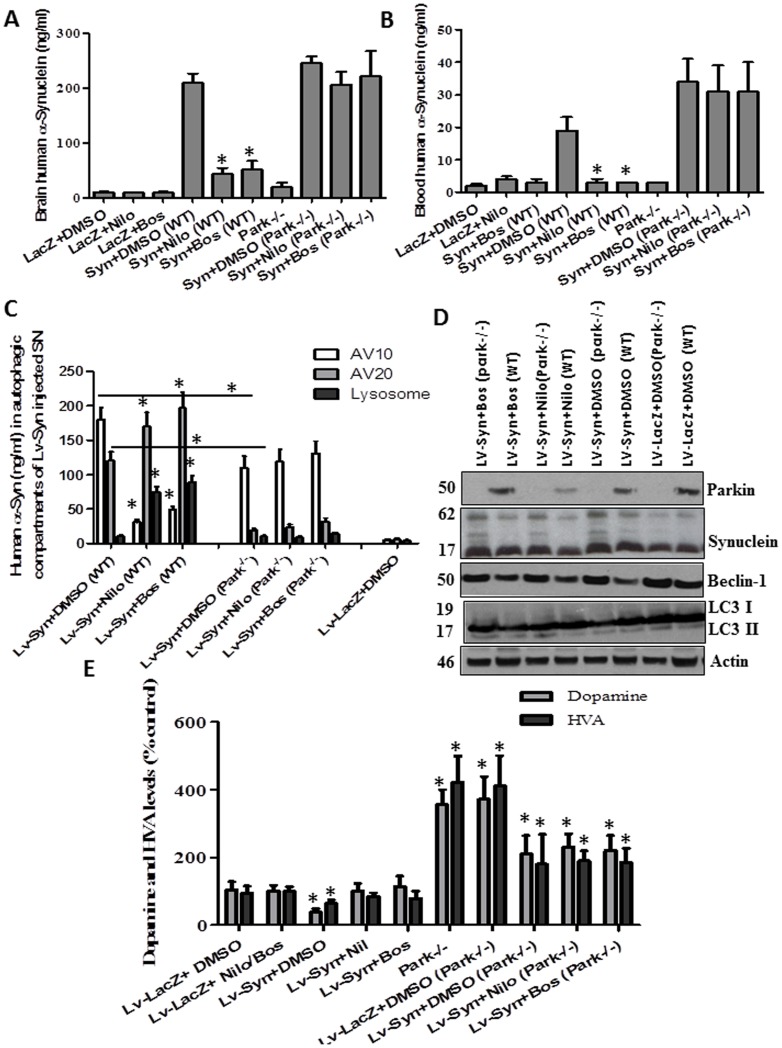
Parkin deletion increases α-Synuclein secretion from the brain into the blood.Histograms represent ELISA in WT and parkin−/− mice stereotaxically injected with lentiviral human α-Synuclein or LacZ showing α-Synuclein levels in A) brain lysates and B) total blood (n = 10) in mice treated with DMSO, 10 mg/kg nilotinib or 5 mg/kg bosutinib for 3 weeks. C). Histograms represent subcellular fractionation of midbrain lysates and ELISA of human α-Synuclein in AVs of WT and parkin−/− mice after daily I.P. injection with DMSO, 10 mg/kg nilotinib or 5 mg/kg bosutinib for 3 weeks (n = 5). D) WB on 4−12% SDS-NuPAGE gel showing parkin (1st blot), α-Synuclein (2nd blot) Beclin-1 (3rd blot) and LC3-I/LC3-II (4th blot) relative to actin (5th blot). E). Histograms represent dopamine and HVA levels in total brain lysates in WT and parkin−/− mice injected with lentiviral α-Synuclein or LacZ and treated with daily I.P. of DMSO, 10 mg/kg nilotinib or 5 mg/kg bosutinib for 3 weeks (n = 10). Asterisk indicates significantly different, means±SEM, ANOVA, Newman Keuls, p<0.05.